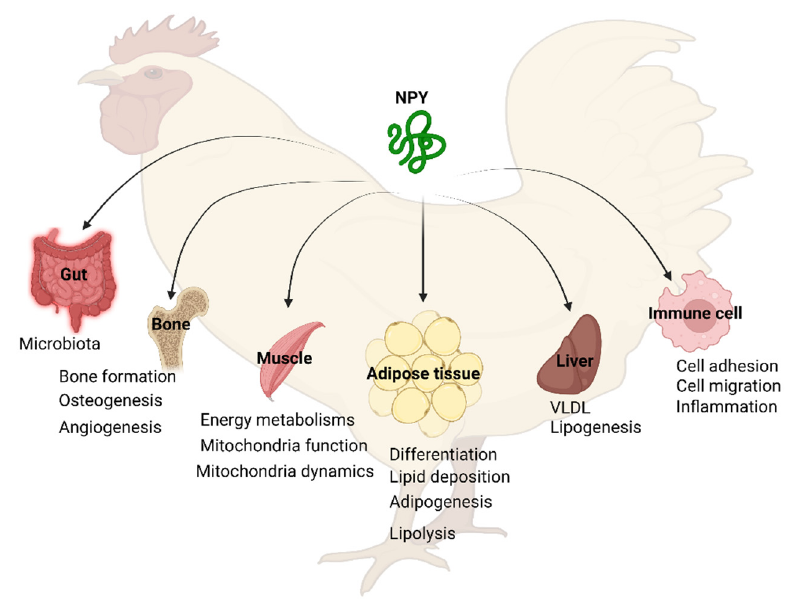
Figure 4. Peripheral physiological functions of NPY. VLDL, very low-density lipoprotein. The figure was made using Biorender.com.